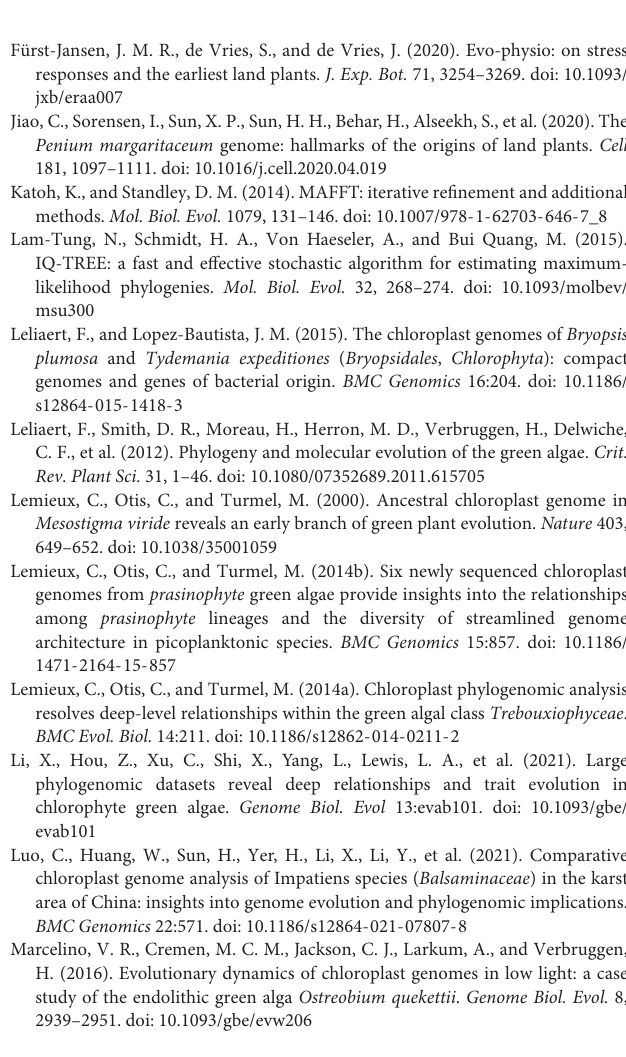
Supplementary Table 1 | GenBank accession numbers and features of Chlorophyta used in this